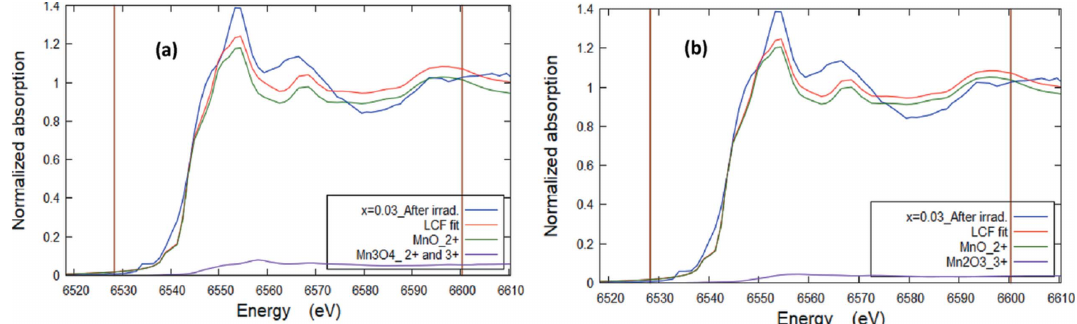
Figure 9 Linear combination fitting (LCF) of the XANES signal at the Mn K -edge with respect to the standard MnCl 2 and Mn 3 O 4 compounds ( a ), and to MnCl 2 and Mn 2 O 3 standards ( b ), respectively. The XANES signal in the range (cid:6) 20 eV to 57 eVof the irradiated sample at x = 0.03 is a representative